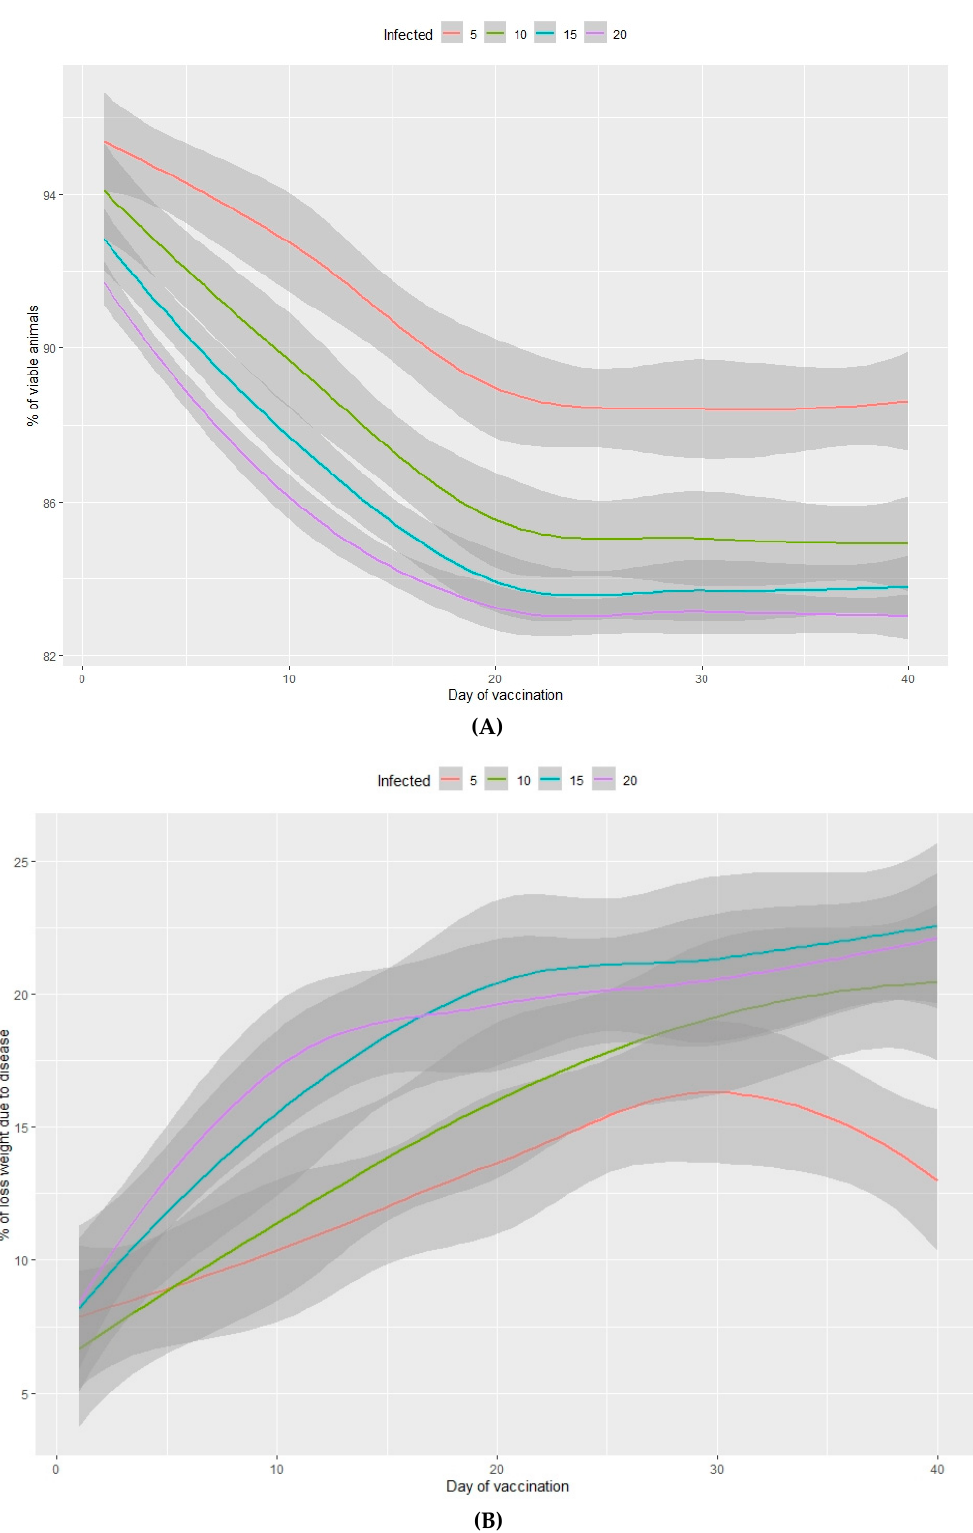
Figure 3. Percentage of viable animals ( A ) and percentage of total weight lost ( B ) at the end of the nursery period in relation to the percentage of infected animals (from 5–20%) and the number of days between infection and vaccination of 100% of the population.